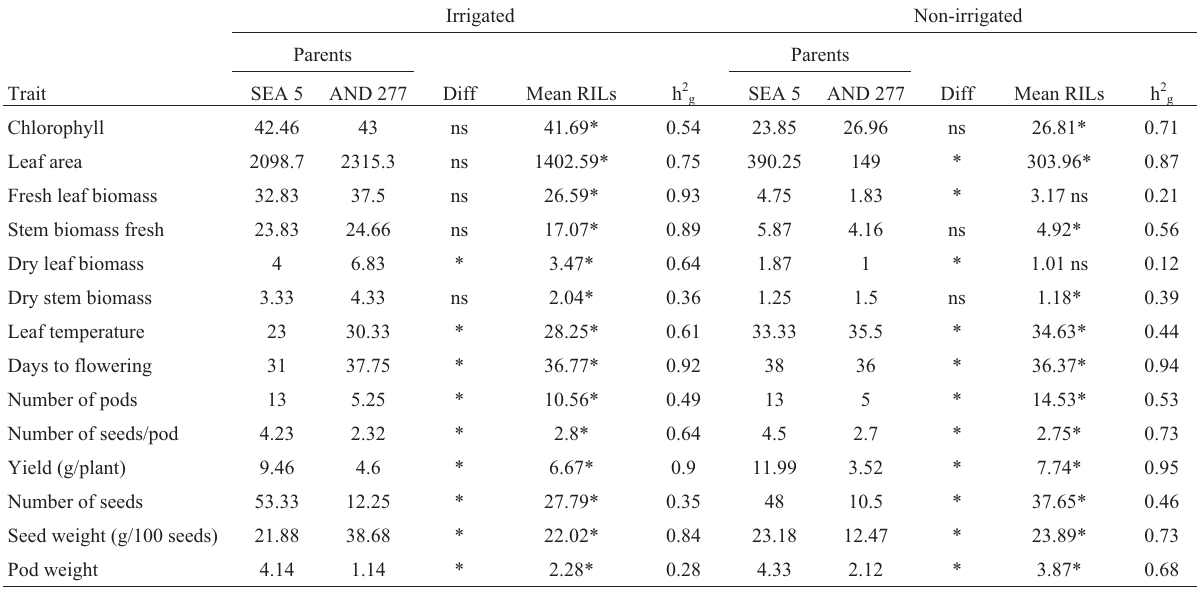
Table 2 - Analyses of variance for quantitative traits for AND 277, SEA 5 and recombinant inbred lines of the AS population evaluated in a greenhouse under irrigated and non-irrigated (water-stressed) conditions.